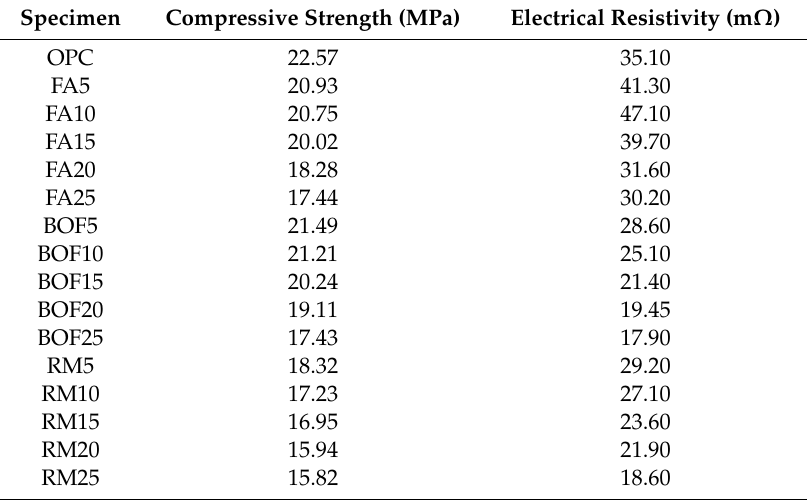
Table A2. Compressive strength and electrical resistance results for the environment-friendly, self-sensing concrete cured at the age of 7 days.